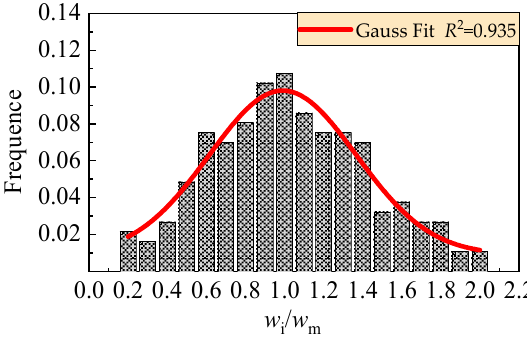
Figure 8. Statistical analysis of distribution of crack width.